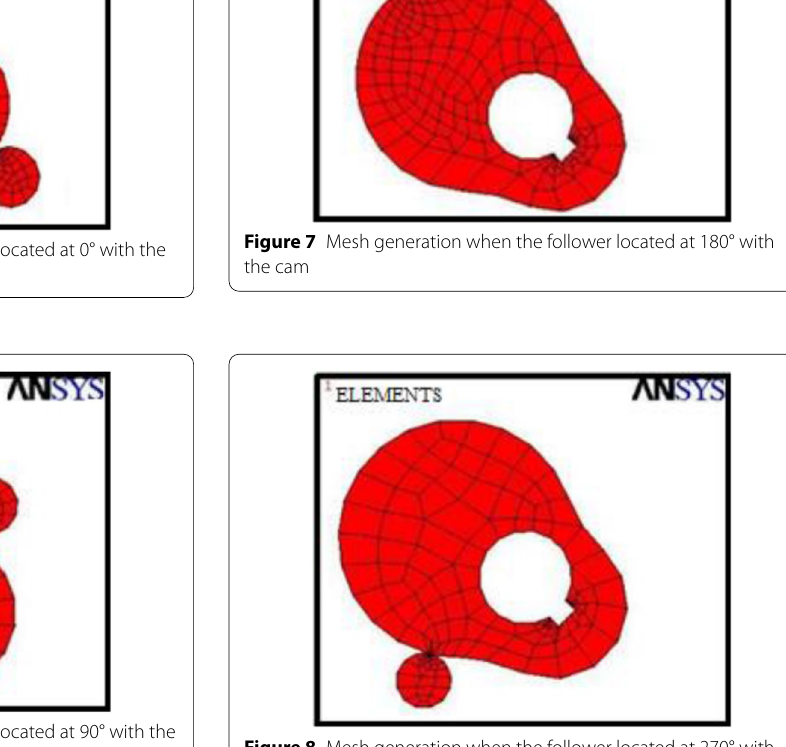
Figure 8 Mesh generation when the follower located at 270° with the cam